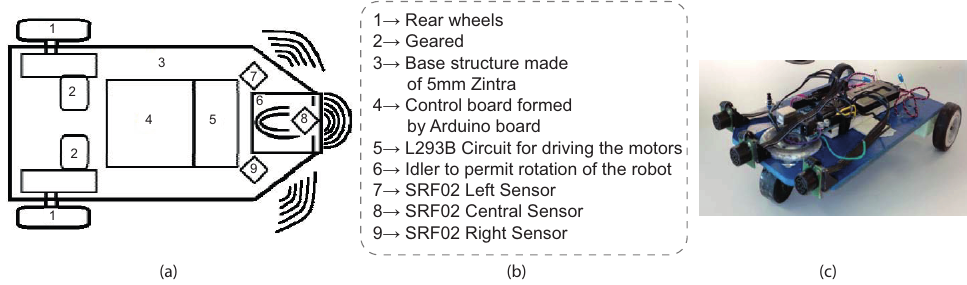
Figure 7. ( a ) Mechanical structure of robot (top view); ( b ) list of devices; ( c ) mobile robot prototype.